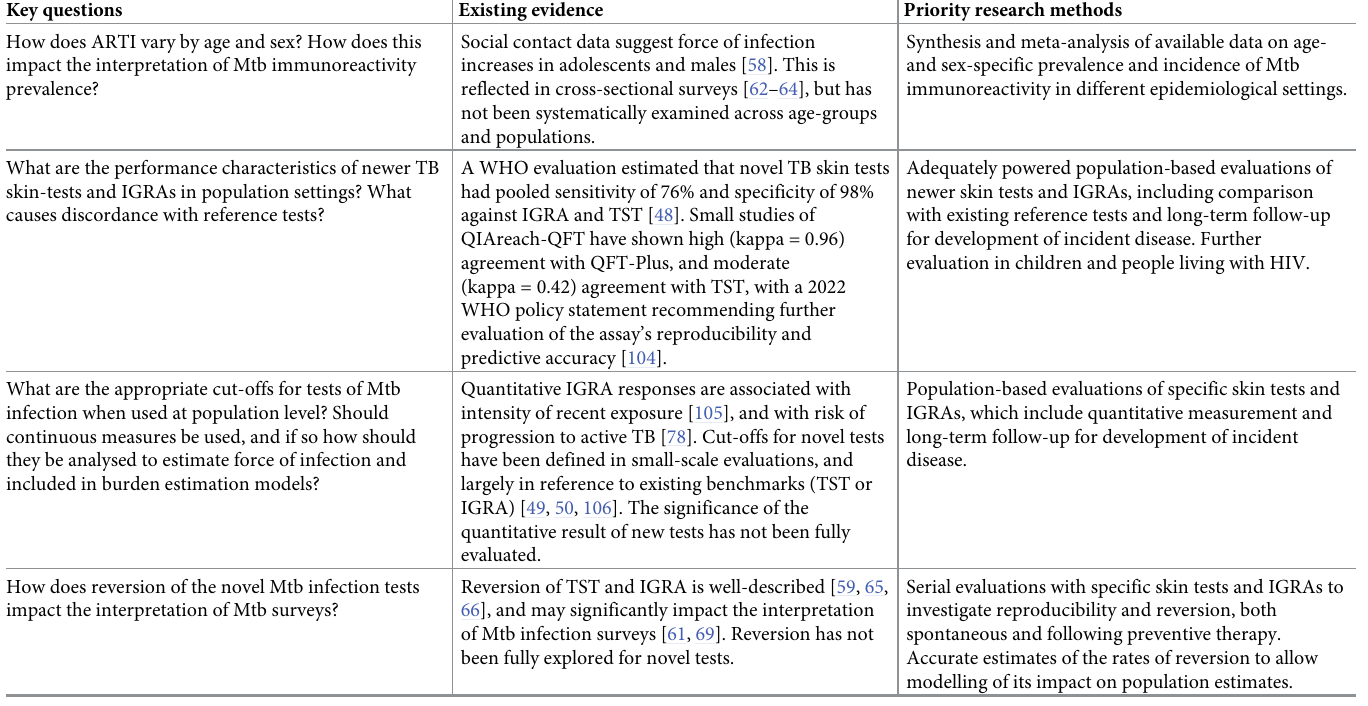
Table 3. Research gaps, existing evidence and priority research methods to inform wider implementation of Mtb infection